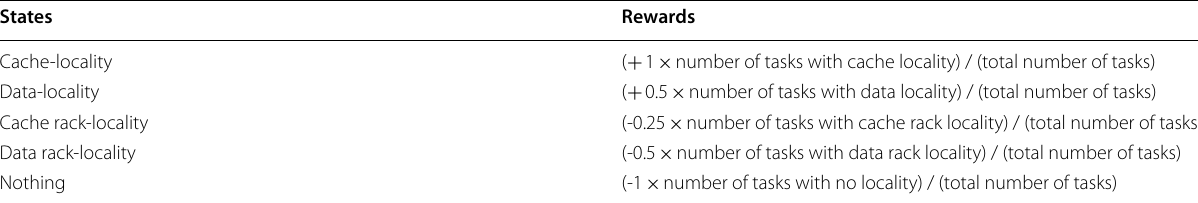
Table 2 Reward values for different states States Rewards